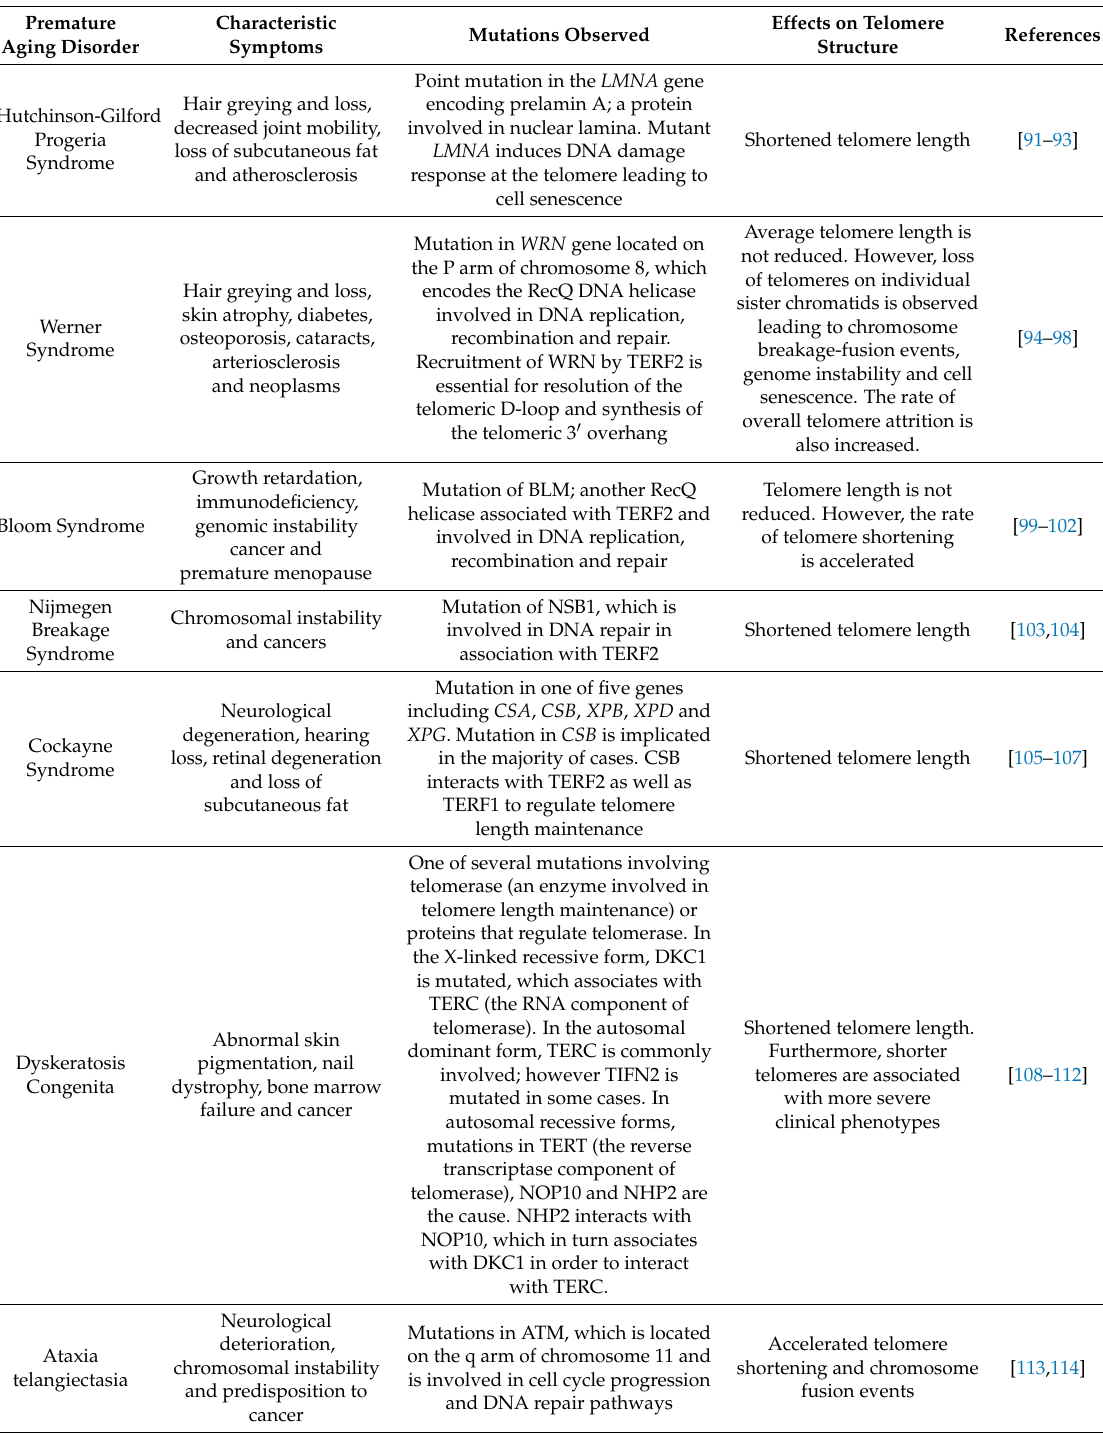
Table 3. Telomere biology in premature aging disorders: Clinical observations and aberrant telomere observations associated with premature aging